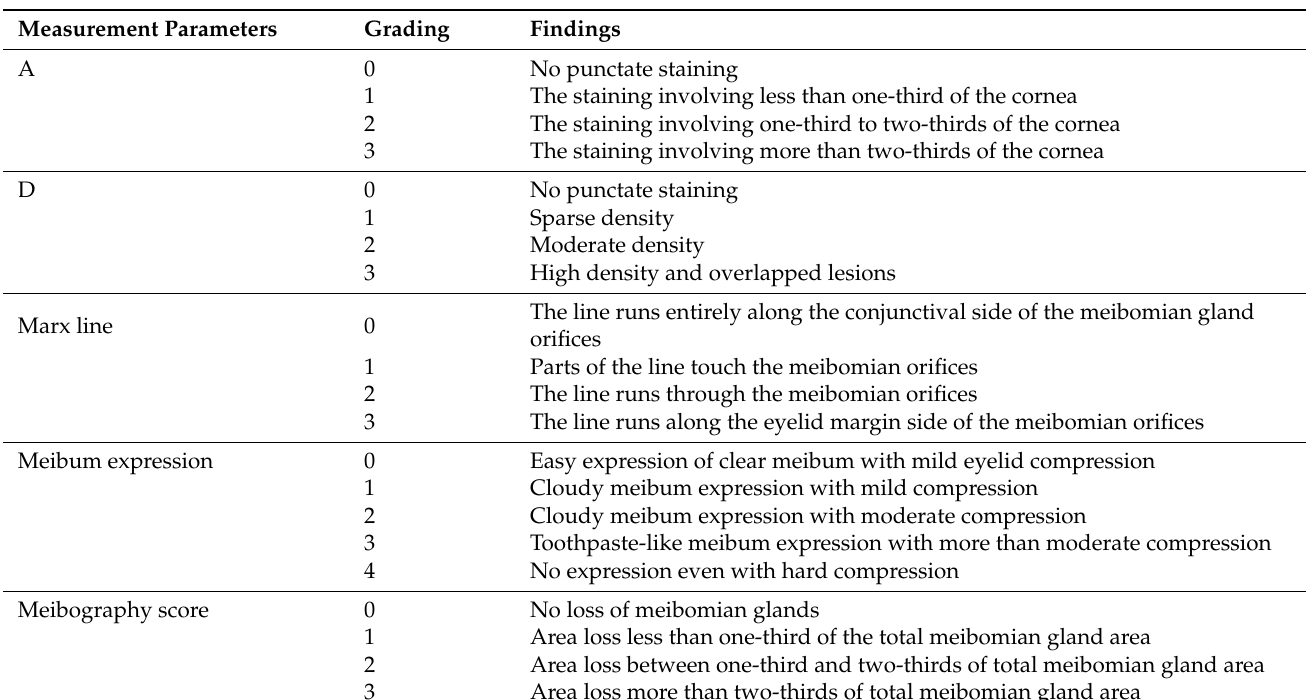
Table 1. The grading systems of measurement